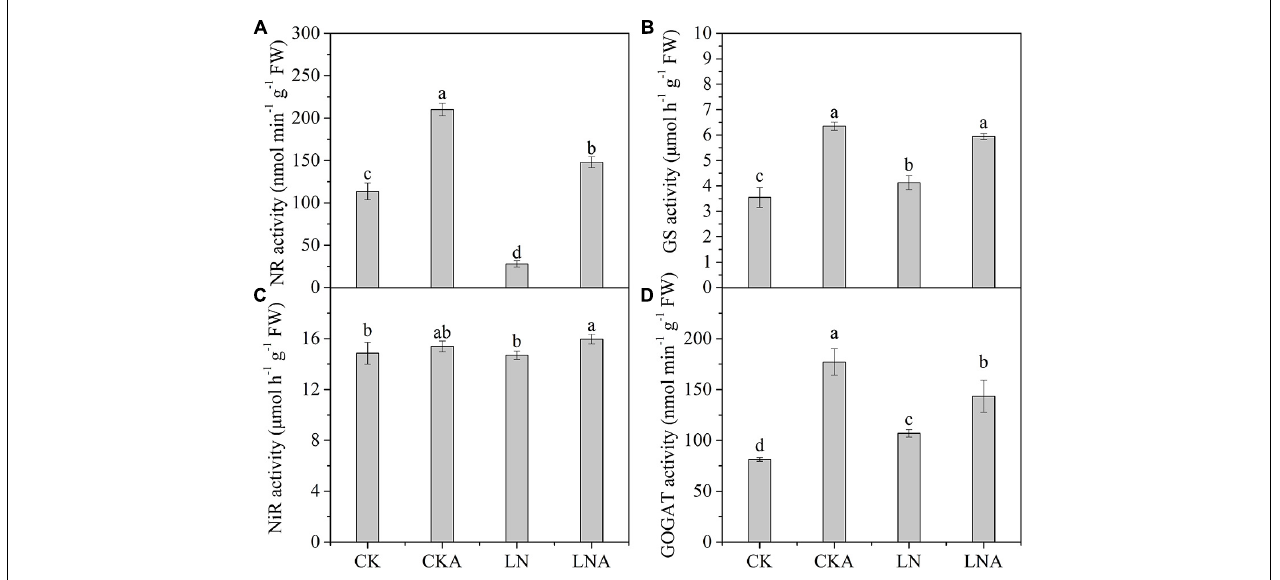
FIGURE 4 | The activity of enzymes in the leaves of CK, CKA, LN, and LNA after 20 days. NR activity (A) , GS activity (B) , NiR activity (C) , and GOGAT activity (D) . Values are means of five replicates ± SD. Values not represented by the same letter are significantly different according to Tukey’s multiple-range test ( P < 0.05).